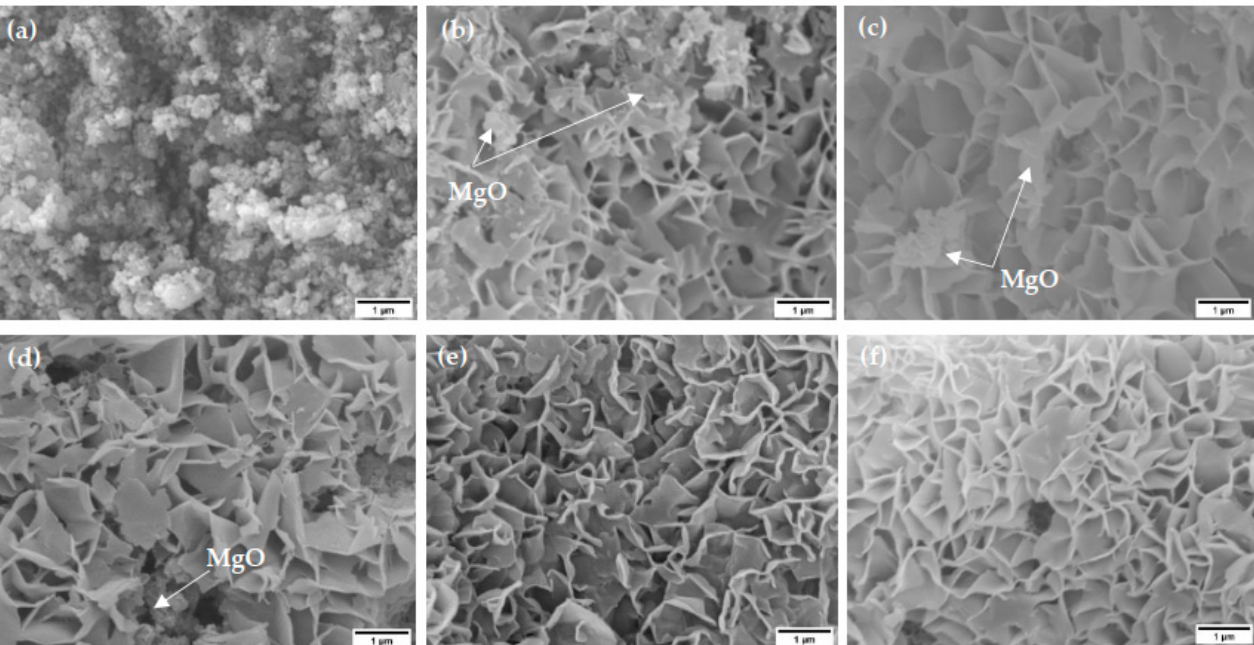
Figure 3. SEM images of electrospun MgO samples ( a ) before exposure to steam (no-steam) and after exposure to steam for ( b ) 2-min, ( c ) 5-min, ( d ) 10-min, ( e ) 15-min, and ( f ) 20-min at 100 °C.